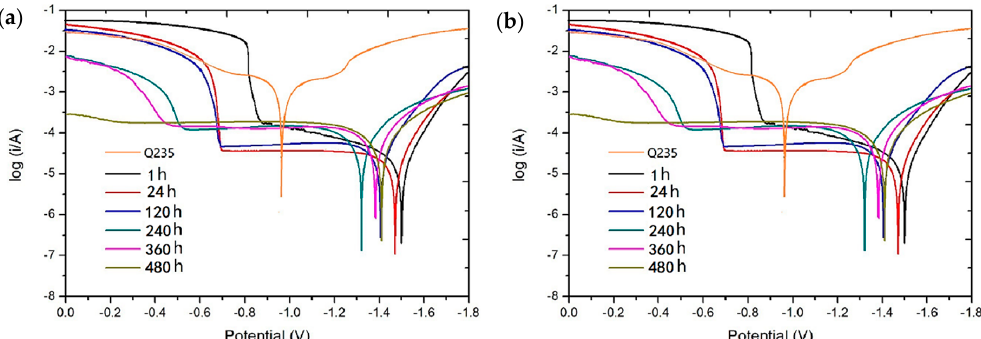
Figure 7. Polarization curves of two composite coatings at 1, 24, 120, 240, 360, and 480 h and polarization curves of matrix steel Q235: ( a ) polarization curves of Zn 45 Al 35 Mg 5 ZnO 15 at di ff erent times and ( b ) polarization curves of Zn 65 Al 15 Mg 5 ZnO 15 at di ff erent